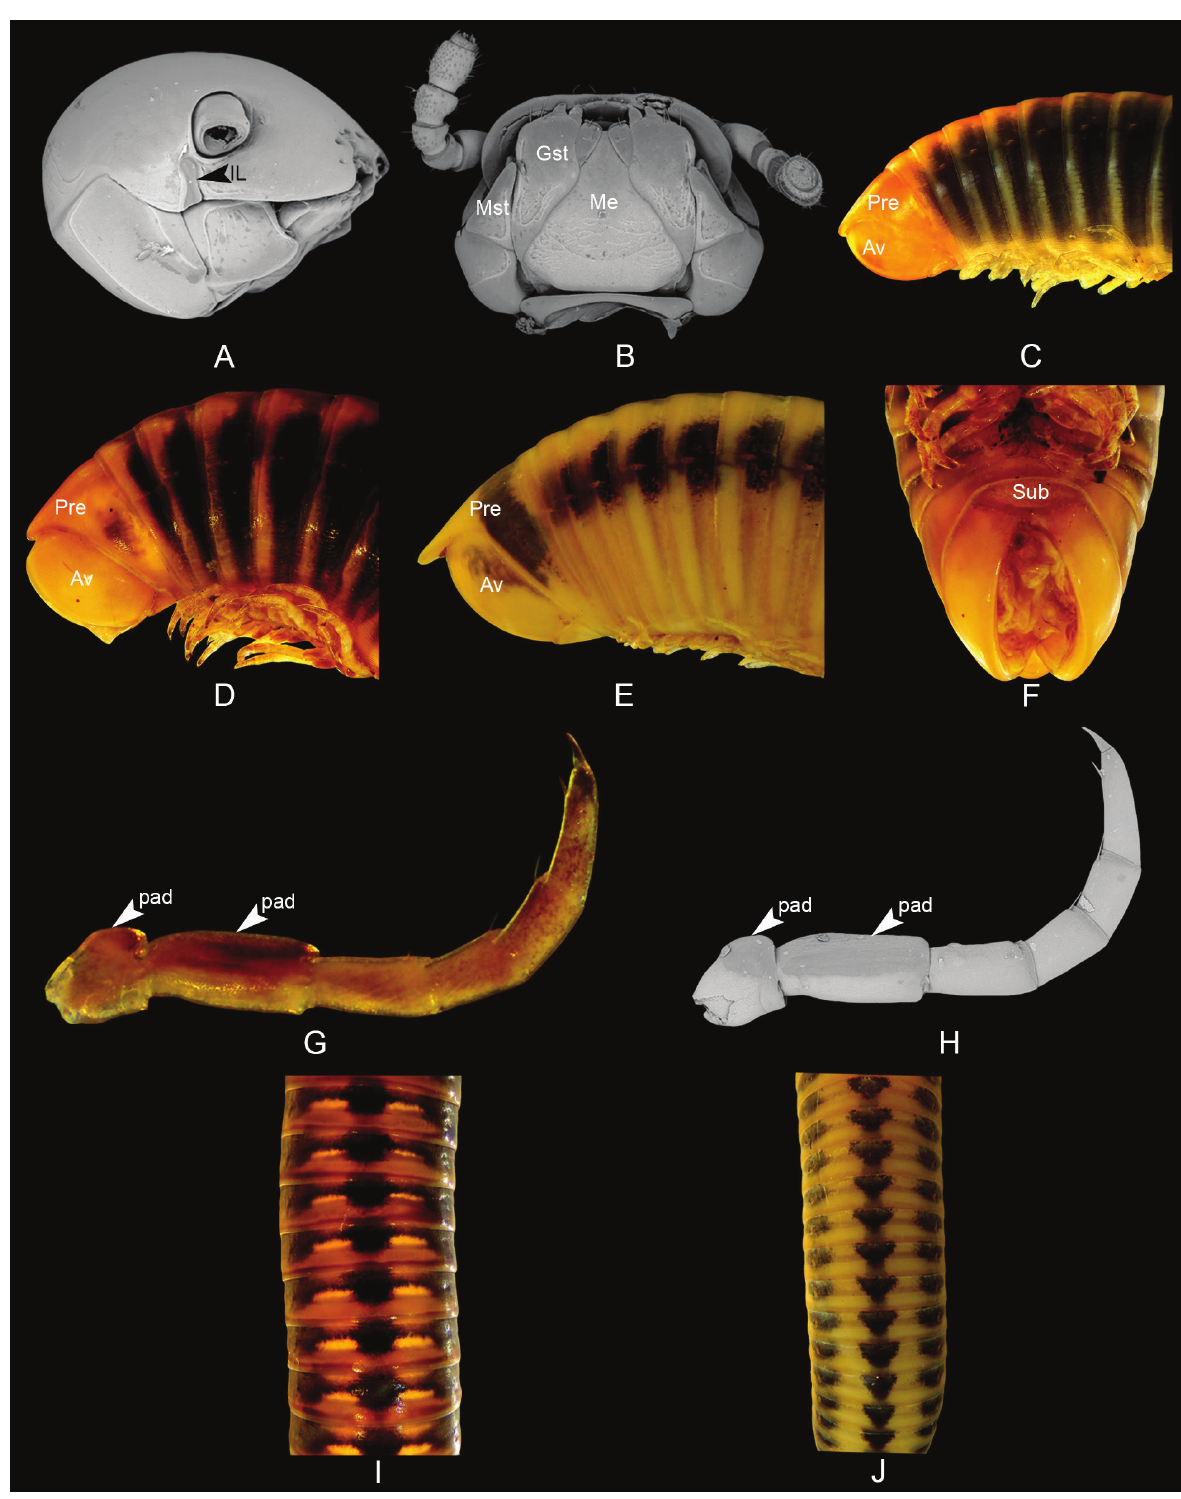
Figure 2. External morphology of Siliquobolellus gen. nov. A – C. S. amicusdraconis gen. et sp. nov. A. Head, lateral view; B. Head, ventral view; C. Posterior end, lateral view; D. Posterior end, lateral view ( S. prasankokae gen. et sp. nov.); E. Posterior end, lateral view ( S. constrictus gen. et sp. nov.); F–I. S. prasankokae gen. et sp. nov.; F. Posterior end, ventral view; G, H. Male leg, latero-ventral view; I. Body rings, dorsal colour pattern; J. S. constrictus gen. et sp. nov., body rings, dorsal colour pattern. Av = anal valves; Gst = gnathochilarial stipes; IL = incisura lateralis Me = mentum; Mst = Mandibular stipes; Pre = preanal ring; Sub = subanal